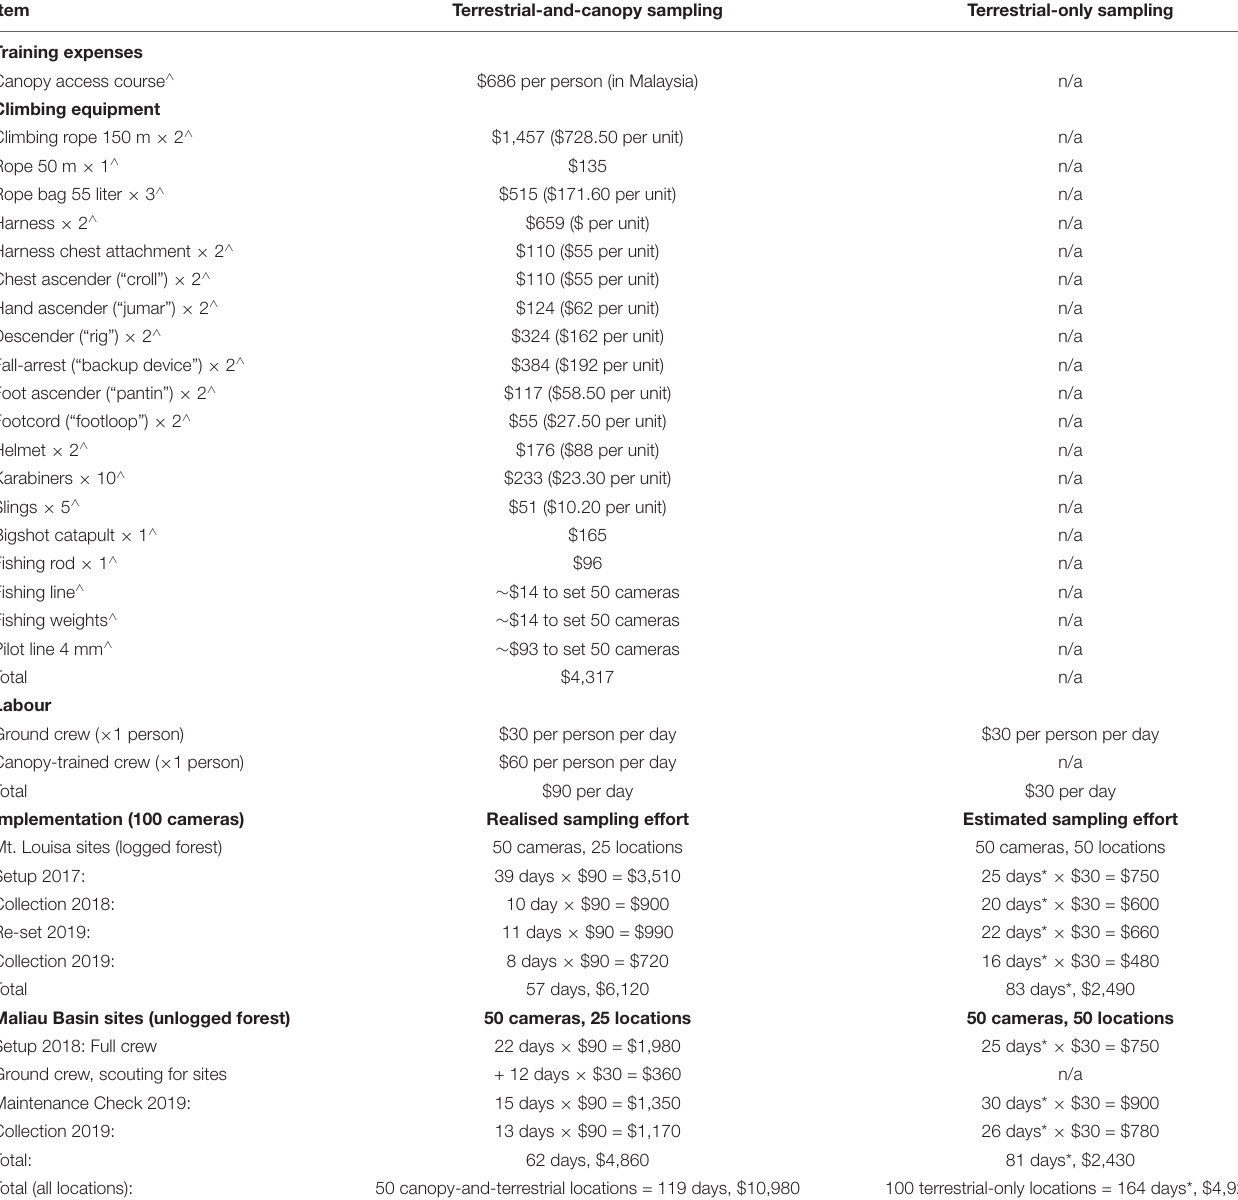
TABLE 2 | Costs (US dollars) of terrestrial-only versus terrestrial-and-canopy camera-trapping, based on our experience in Sabah, where the cost of equipment hire was incorporated into the increased daily salary for climbing-trained staff.